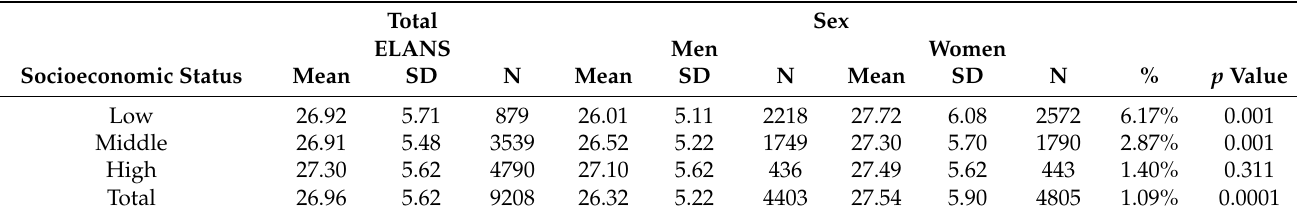
Table 5. BMI among the socioeconomic statuses—the Latin American Health and Nutrition Study (ELANS).